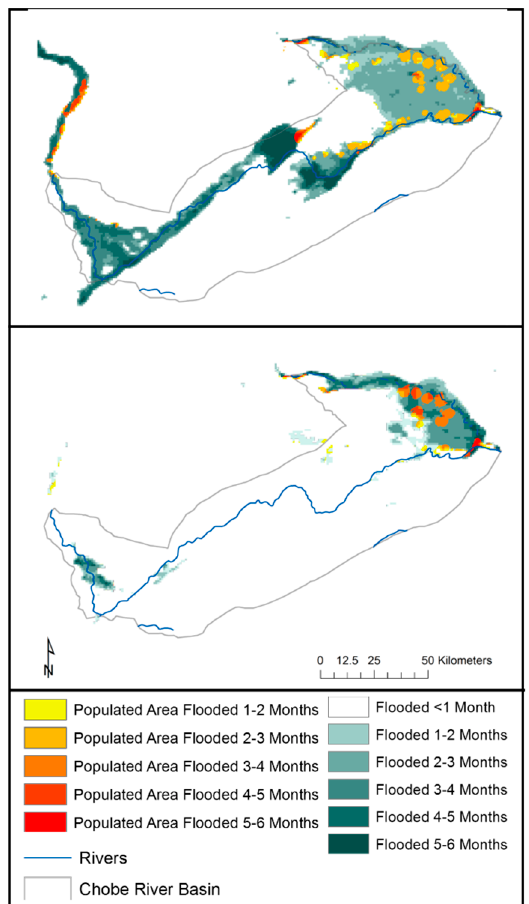
Figure 14. Population centers located within flood zones in years of low magnitude ( top ) and high magnitude flooding ( bottom ).